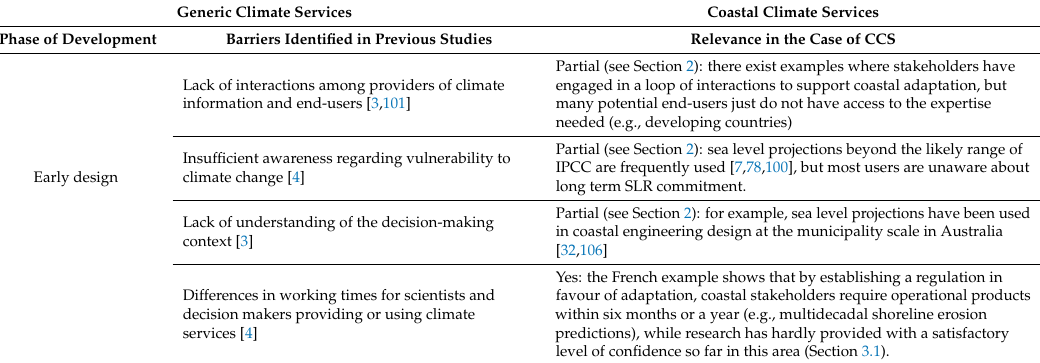
Table 3. Barriers to the uptake of CCS (after: Vaughan and Dessai [3]; Brasseur and Gallardo [4]; Cavelier et al. [18], Brooks [101]; Nuseibeh and Easterbrook [103], Cash et al. [104]; Monfray and Bley